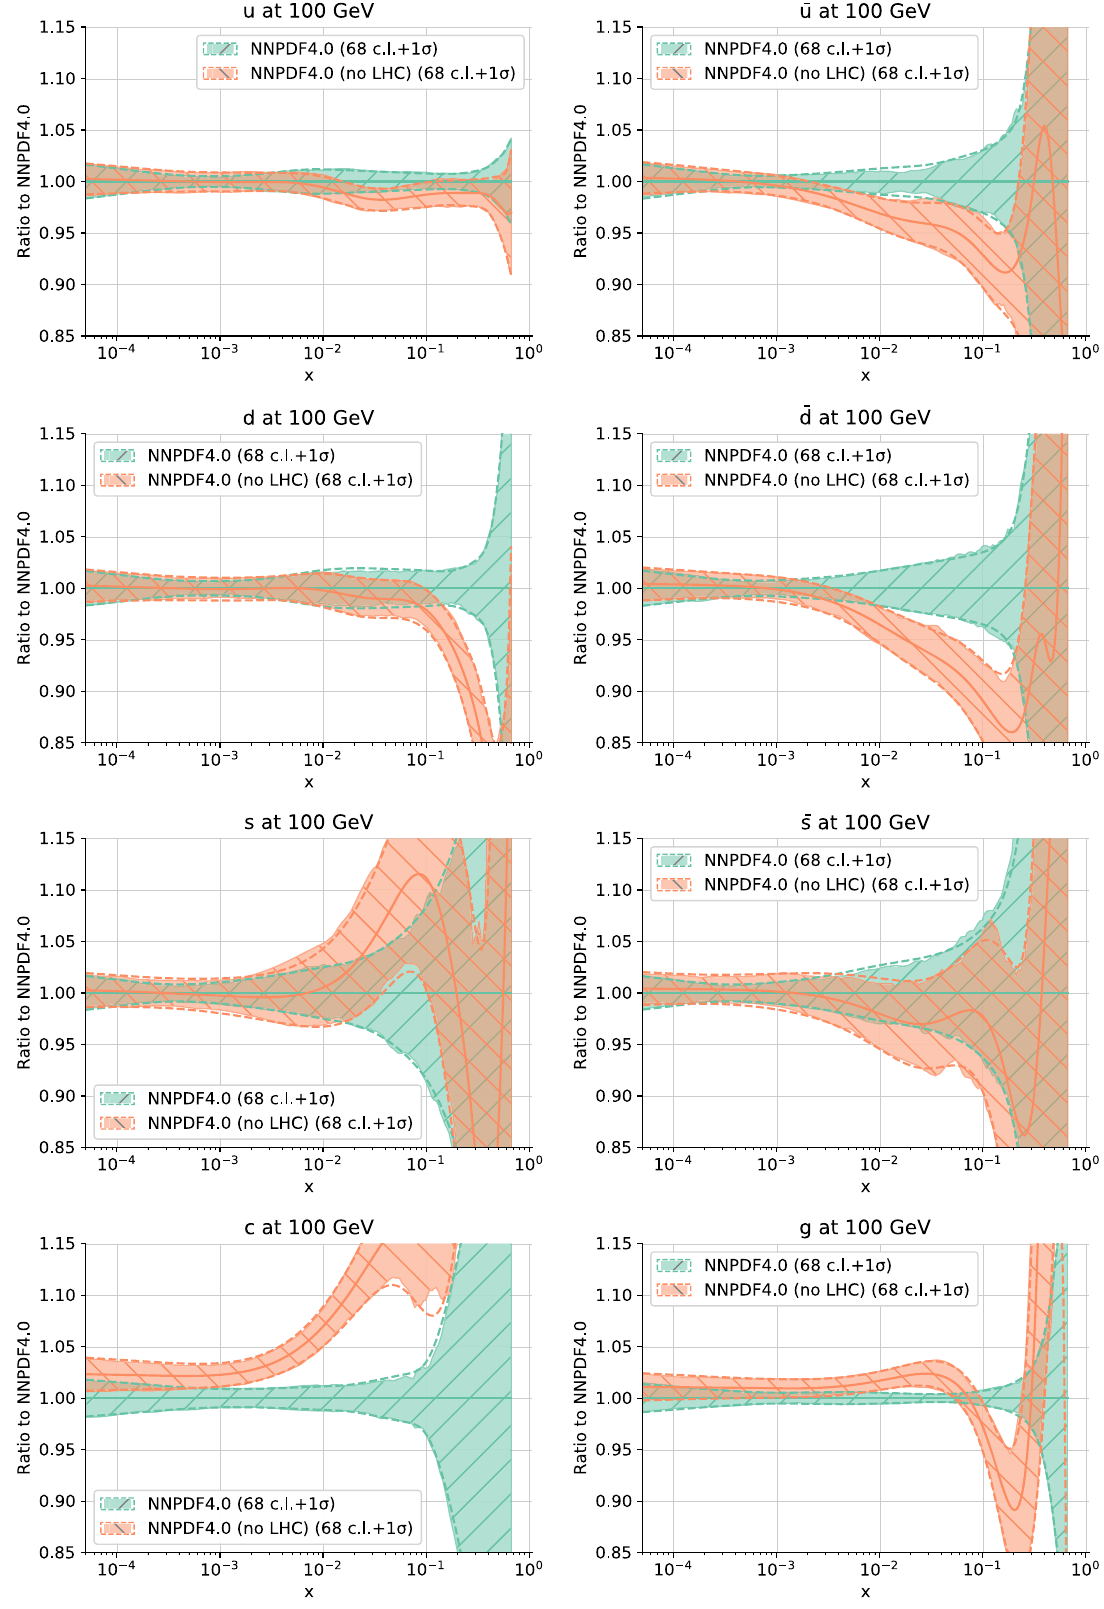
Fig. 38 Same as Fig. 31 now comparing the baseline to PDFs determined removing from the dataset all LHC